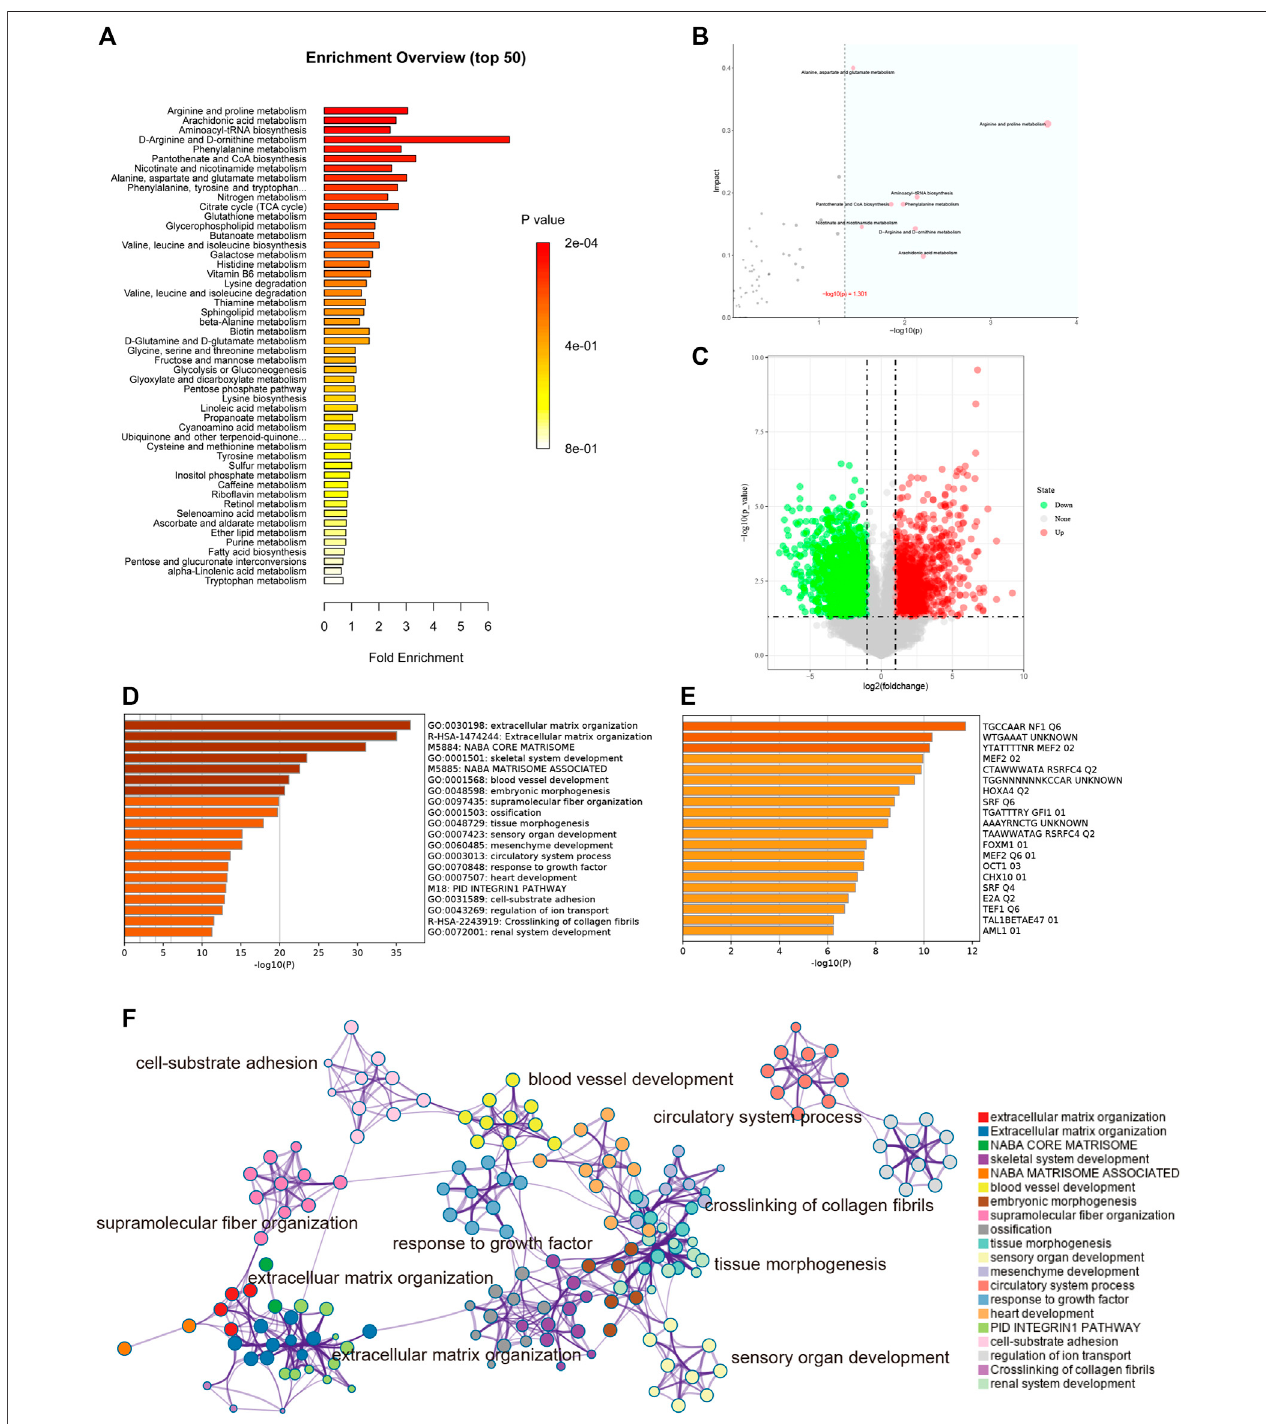
FIGURE 6 | (A) Enrichmentanalysis.Theabscissaistheenrichmentfactor,whichisthenumberofobservedmetabolites/theoreticalmetabolitesinthemetabolicpathway. Thesizeofthe p valueisexpressedbycolor:thedarkerthecolor,thesmallerthe p value. (B) Topologicalanalysis.Theabscissaisthe p value,andtheblueareaissigni fi cant( p < 0.05); the ordinate is the topological analysis impact. (C) The volcano plot illustrates the differentially expressed genes between control and keloid tissues after analysis of the GSE92566 dataset with GEO2R. (D) GO enriched terms are shown, and accumulative hypergeometric p values and enrichment factors were calculated and used for fi ltering.Theremainingsigni fi canttermswerethenhierarchicallyclusteredintoatreebasedonkappa-statisticalsimilaritiesamongtheirgenememberships.Then,akappascoreof 0.3wasapplied asthethreshold tocastthetreeintotermclusters. (E) Transcription factor enriched terms. Thedarker thecolor, thehigher theenrichment score. (F) Metascape analysis. We selected a subset of representative terms from this cluster and converted them into a network layout. More speci fi cally, each term is represented by a circle node,